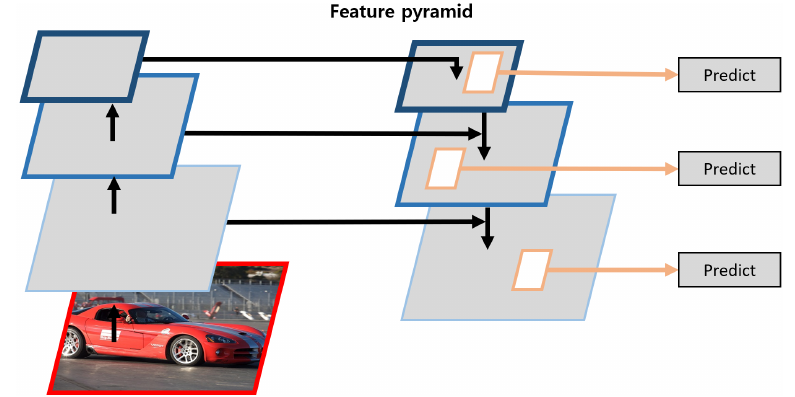
Figure 2. Feature pyramid network